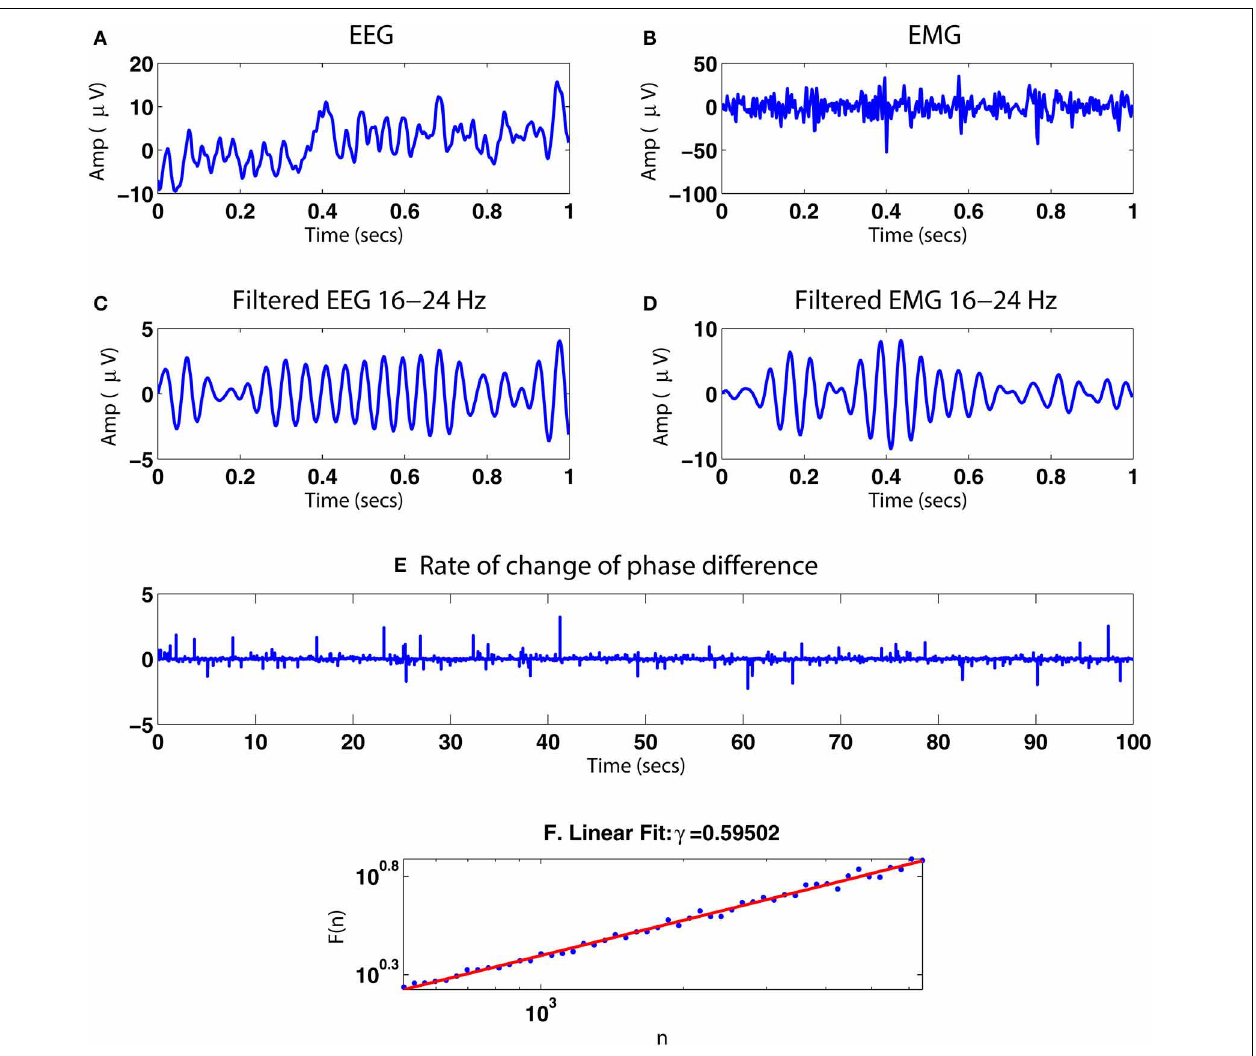
FIGURE 15 | Illustration of the method with simultaneous EEG/EMG data. (A,B) One second of simultaneously recorded EEG and EMG, respectively. (C,D) The signals after bandpass filtering in the β range 16–24Hz. (E) Rate of change of the phase difference between the two